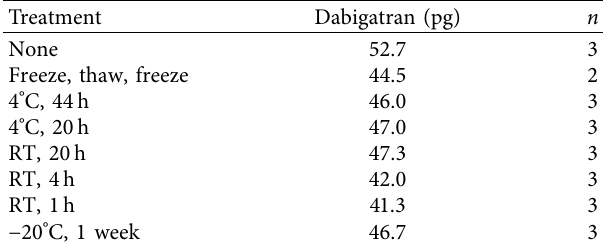
Table 5: Stability testing of triplicates of a 300 μ l aliquot of breast milk containing 48pg of dabigatran. Three technical replicates were treated as indicated, and dabigatran concentration was determined. ANOVA indicated that none of the treatments showed a significant difference in dabigatran concentration. Frozen samples were stored at − 20 ° C for one week. RT � room